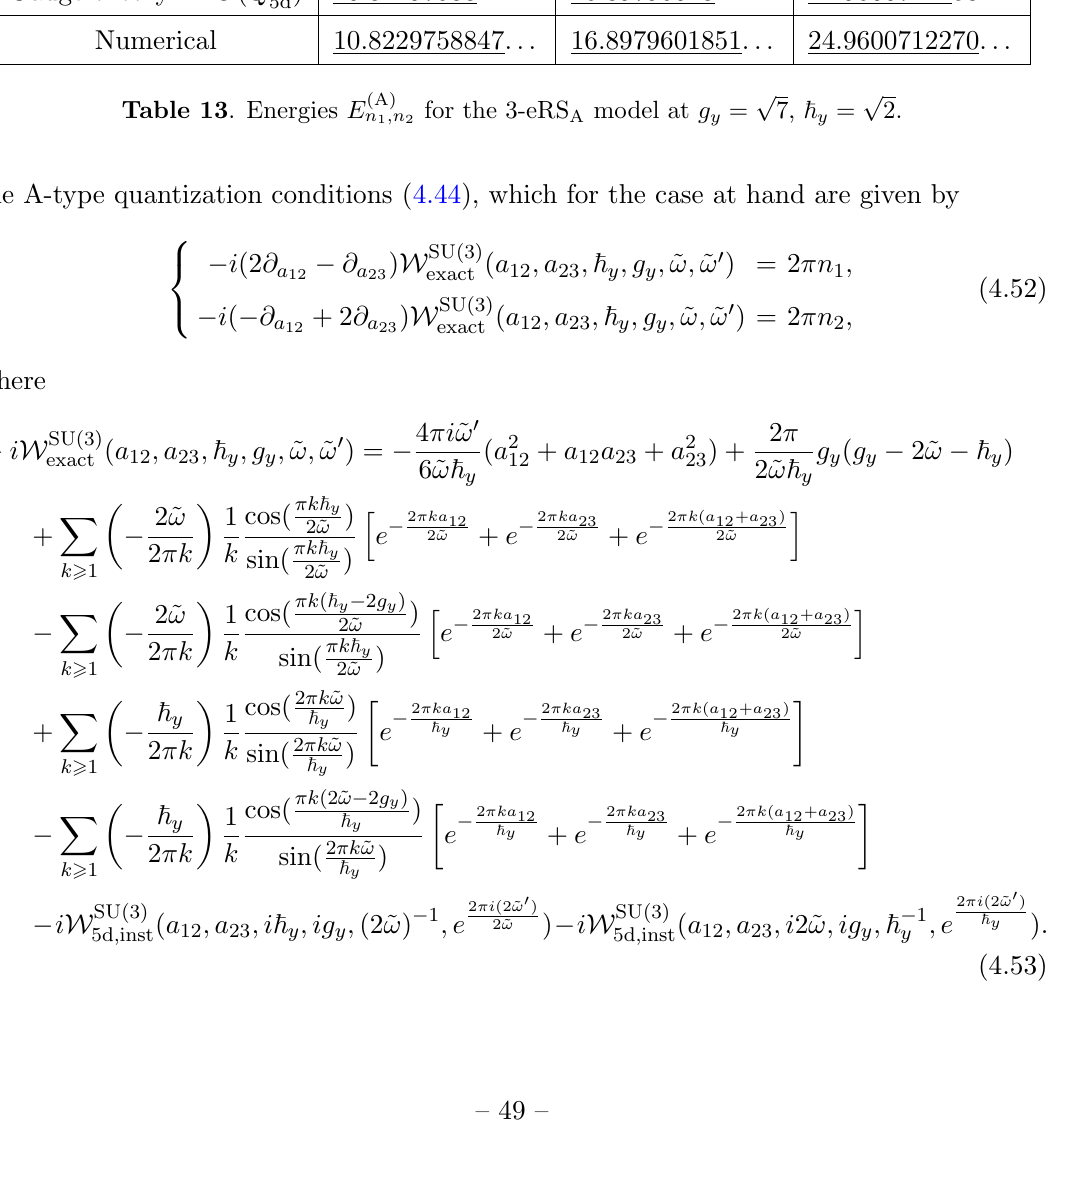
for the 3-eRS A model at g y = 1 ;n 2